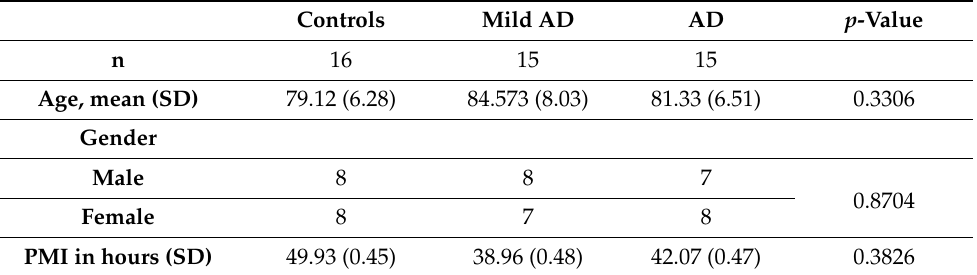
Table 1. Multi-group comparison of available demographic information by one-way ANOVA and chi-square tests. Controls Mild